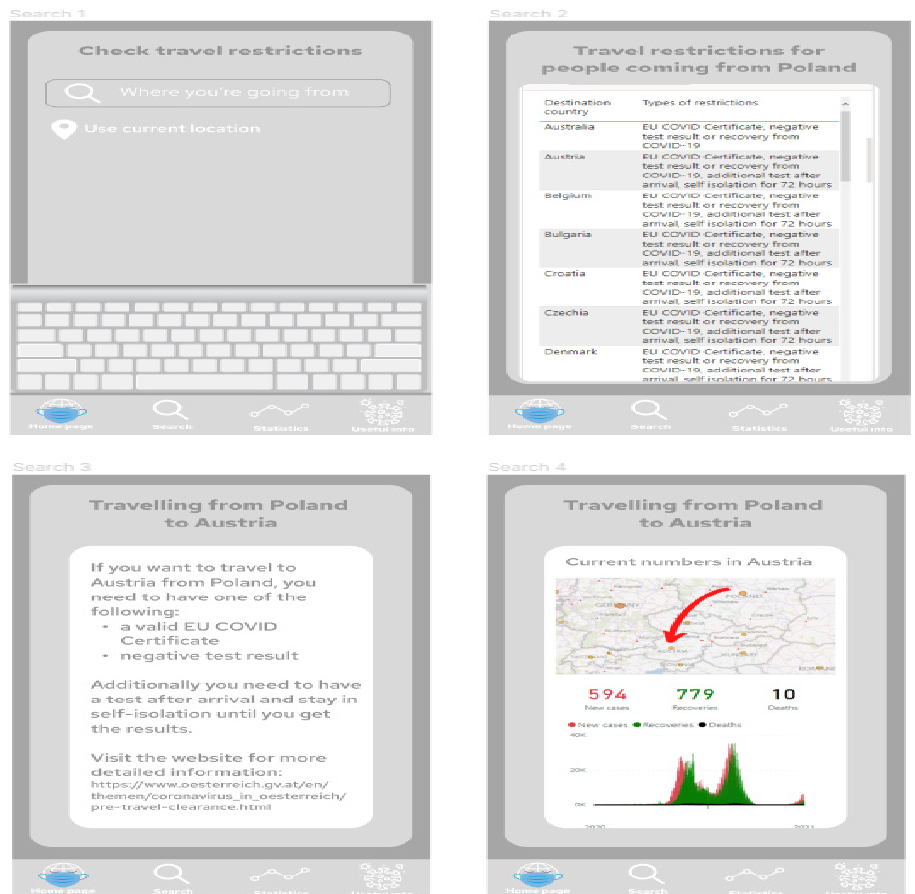
Figure 11. Four screens for searching travel destination and travel restriction details—description of the current restrictions to the chosen country and statistics about COVID-19 at the travel destination. Source: Authors own elaboration.